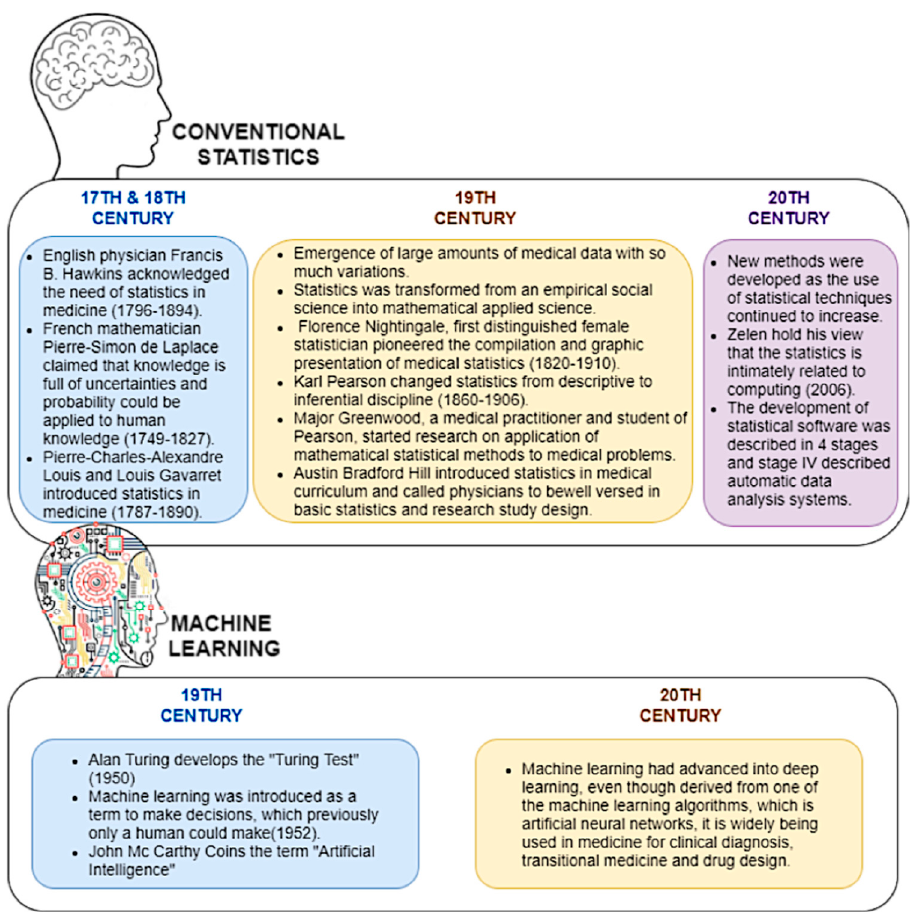
Figure 1. The evolution of conventional statistics and machine learning in health